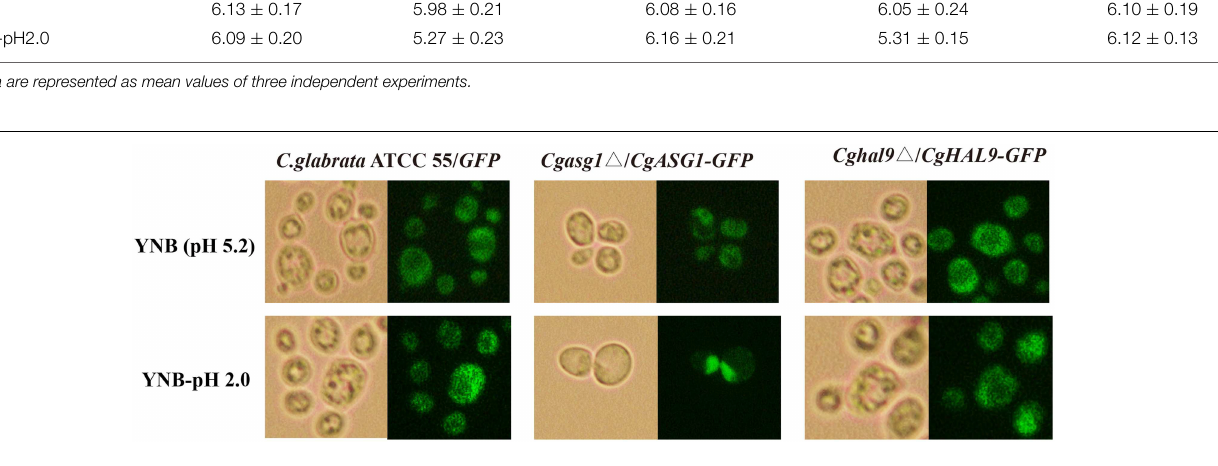
FIGURE 4 | CgAsg1p, but not CgHal9p, accumulates in the nucleus under acid-stressed conditions. CgASG1 and CgHAL9 were fused to the green fluorescent protein (GFP) and expressed in the Cgasg1 1 and Cghal9 1